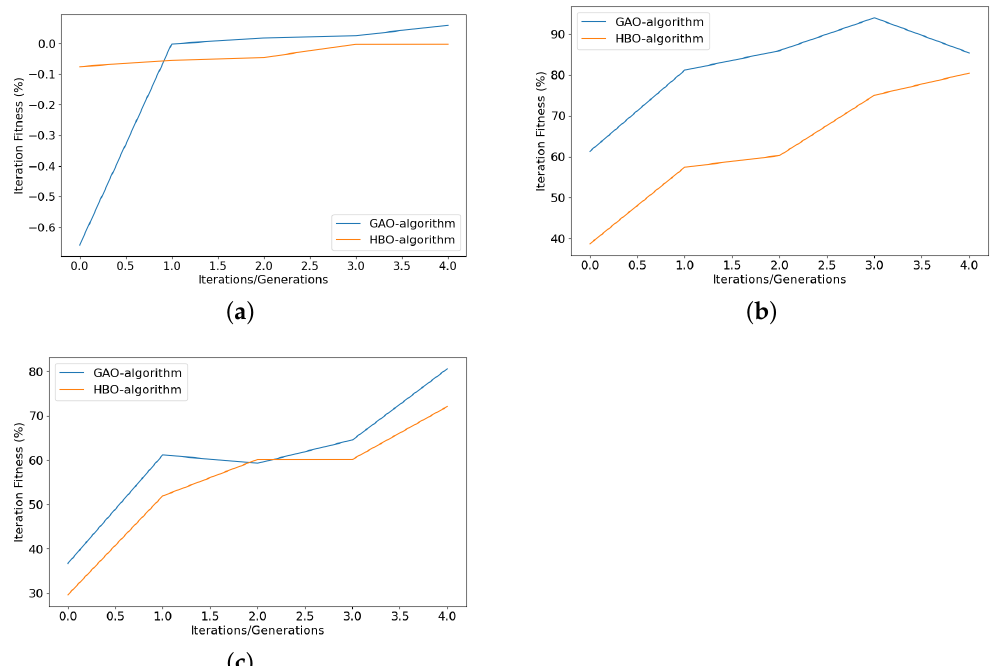
Figure 7. Comparison between HBO-algorithm and GAO-algorithm using Iteration Fitness Perfor- mance parameter for 5 iterations (5 generations for GAO-algorithm): ( a ) Iteration Fitness for High Frequency Component of the original data ( b ) Iteration Fitness for Low Frequency Component of the original data ( c ) Iteration Fitness for the original